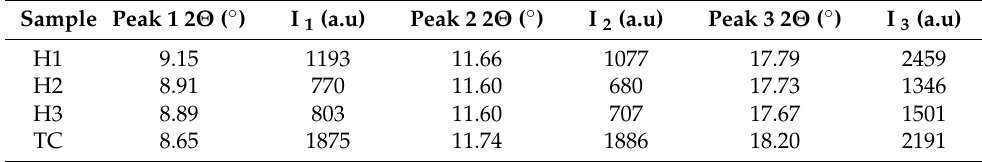
Table 2. The intensities for three visible diffraction peaks for the samples 1, 2, 3 and commercial TC. Sample Peak 1 2 Θ ( ◦